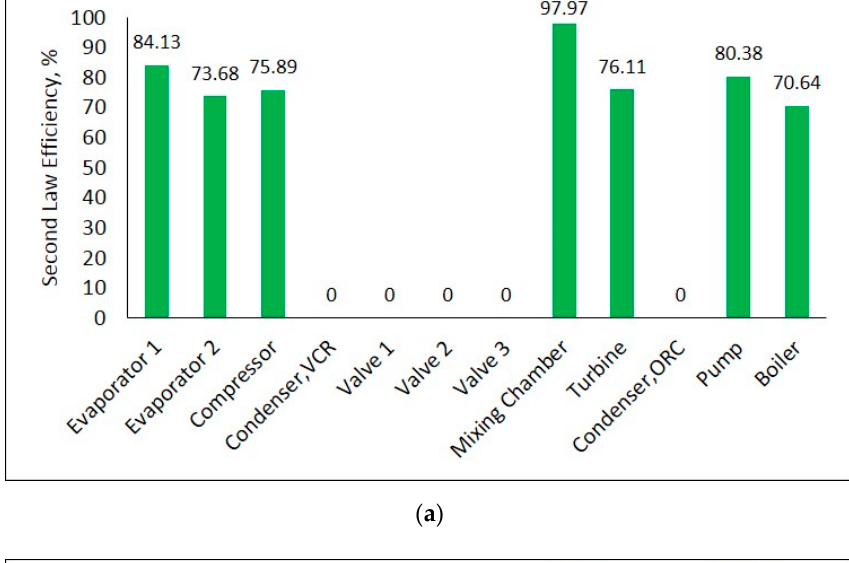
Table 8. Comparison of proposed systems.